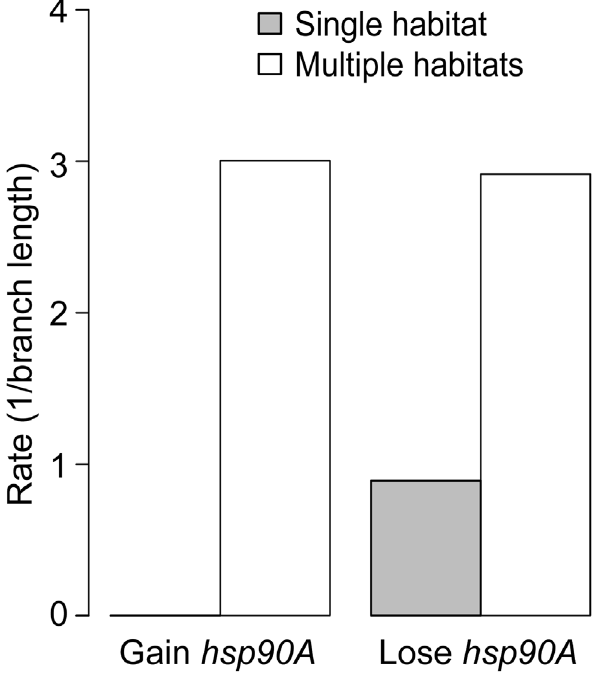
Figure 6. Habitat preference affects the gain and loss of hsp90A in bacteria. Rates of gain and loss of hsp90A throughout bacterial evolution with relation to multiple habitat preference. Standard deviation across 100 runs was smaller than 0.001 in all cases.